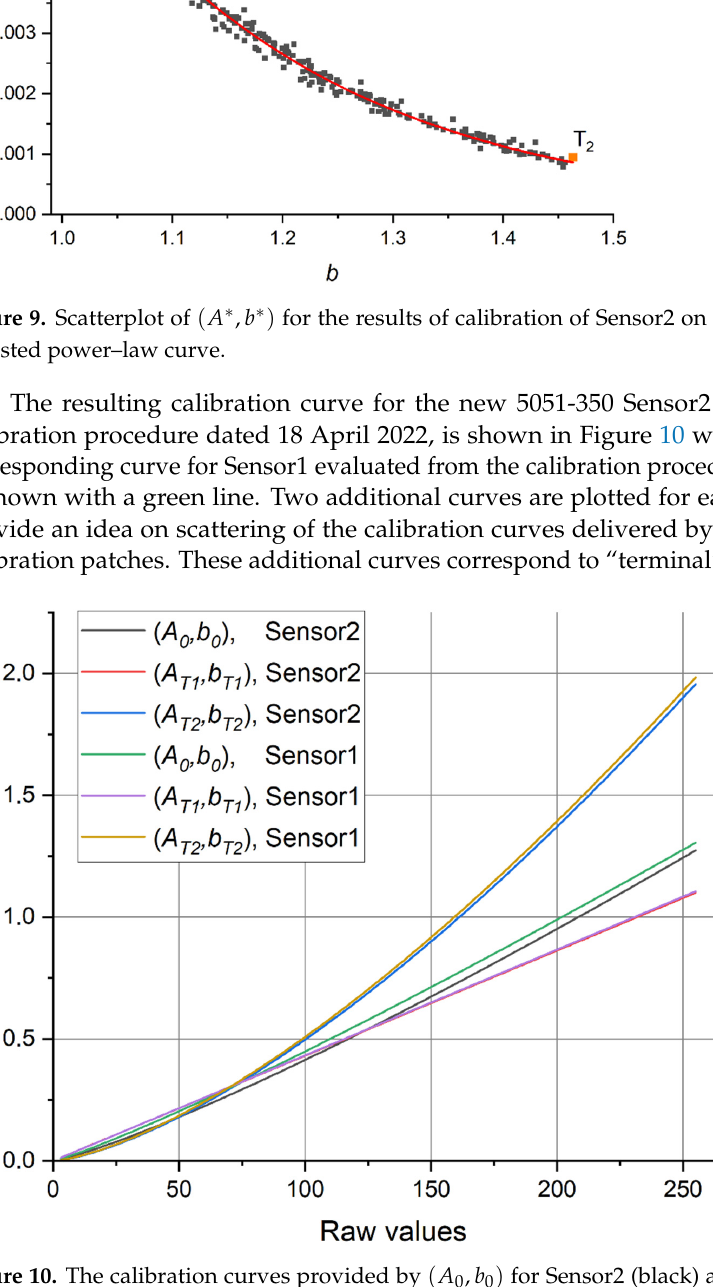
Figure 11. Discrepancy of the applied load on Sensor2 (150 calibration patches) with the load calcu ‐ lated by means of calibration Formula (1) utilizing the parameters (cid:4666)𝐴 (cid:2868) ,𝑏 (cid:2868) (cid:4667) . 6. Conclusions The uniform loading of a tactile sensor to obtain a number of calibration patches with evenly distributed pressure is usually a technically challenging task. This procedure is especially difficult if it is required to obtain evenly distributed high pressures. At the same time, calibration patches with high pressures are necessary for the correct calibration of